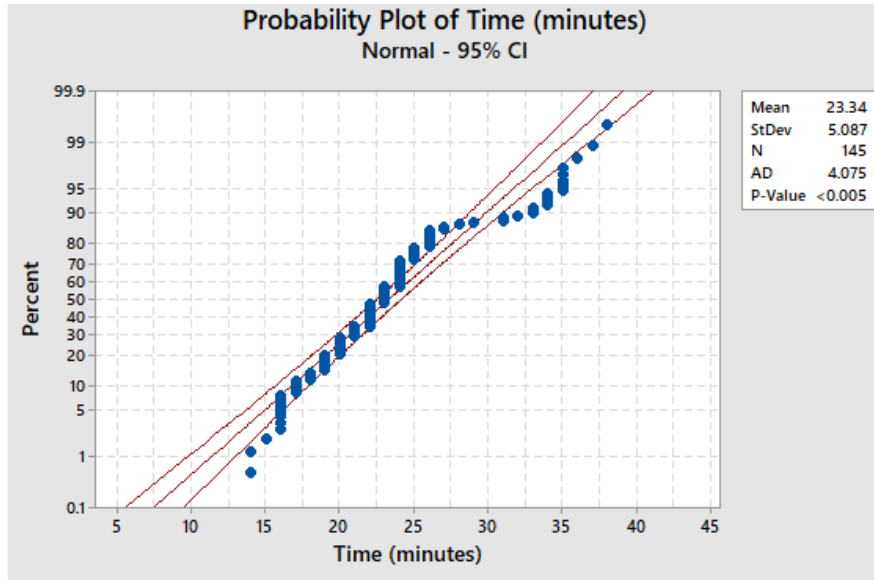
Figure 3. Normal probability plot for waiting time